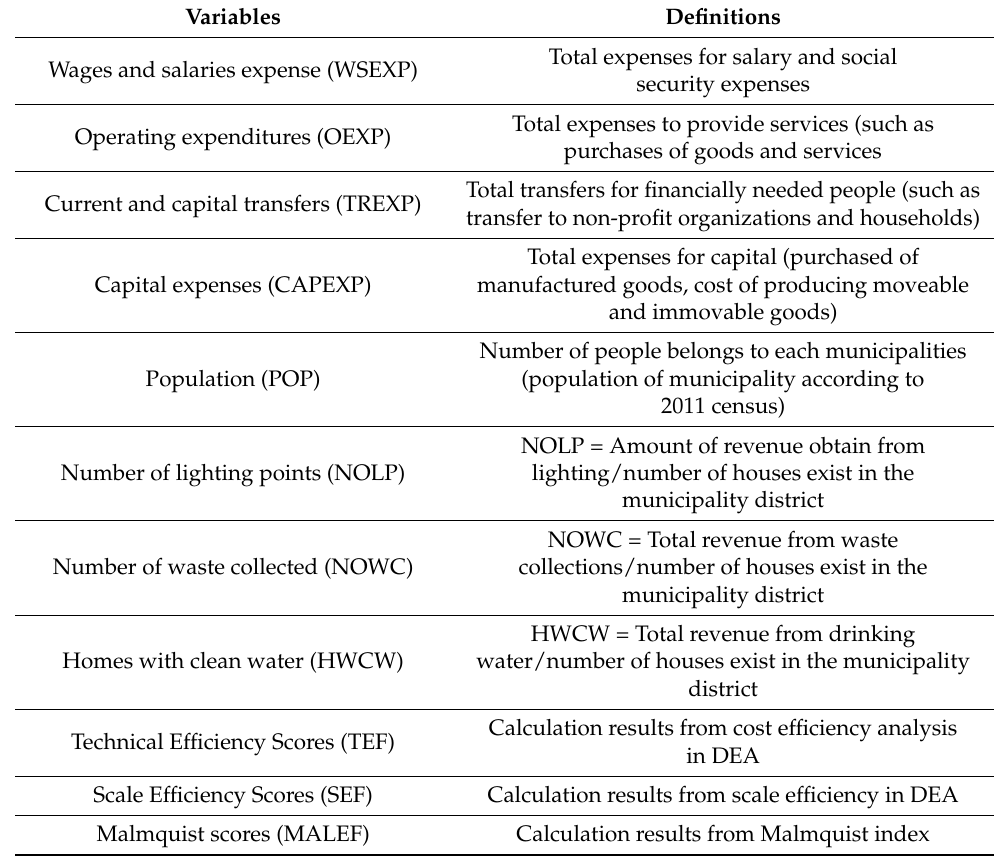
Table 6. Definition of